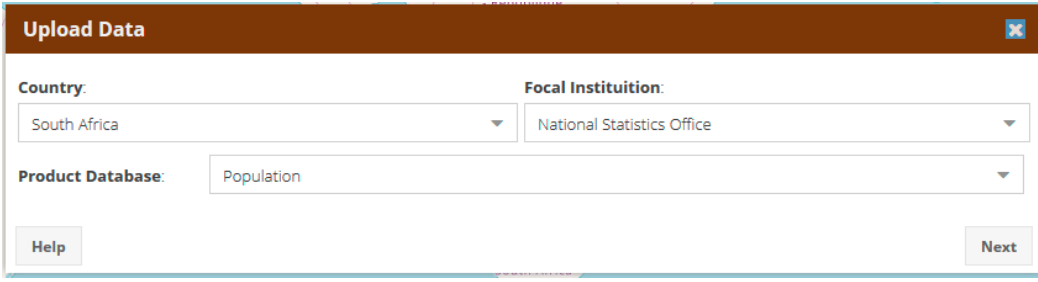
Figure 7. Data upload capabilities for data updating and sharing.